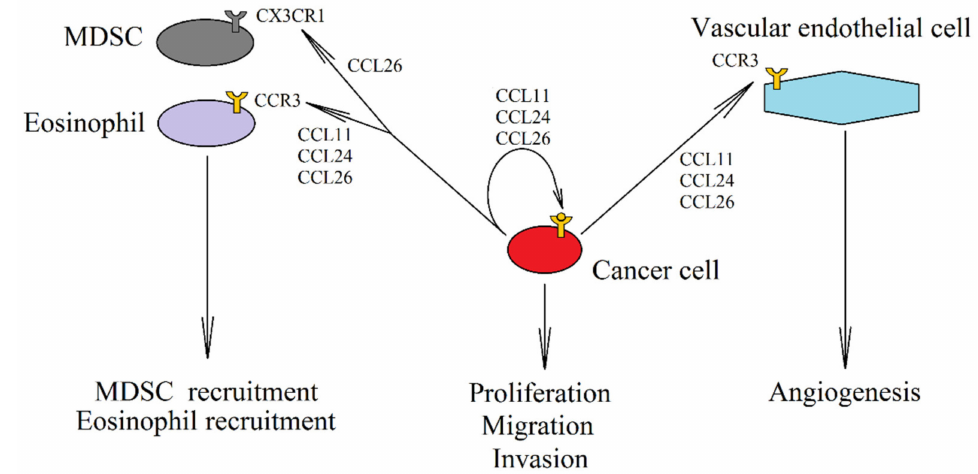
Figure 2. The role of eotaxins in cancer. In a neoplastic cell there is an expression of CCL11 (eotaxin-1), CCL24 (eotaxin-2) and CCL26 (eotaxin-3). This increases the autocrine proliferation and causes